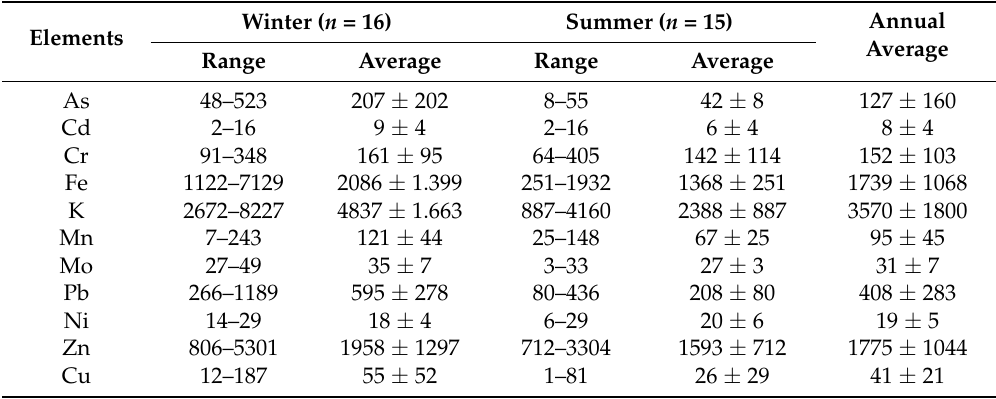
Table 1. Concentrations of eleven elements in PM 2.5 during winter and summer in Xi’an (Unit: ng m − 3 ).